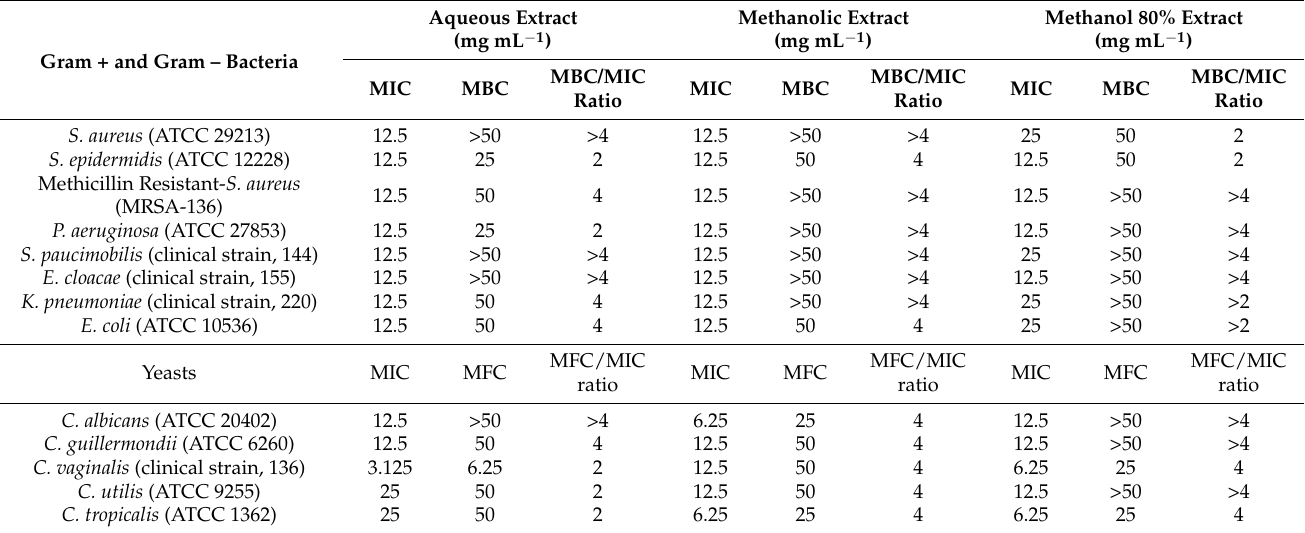
Table 6. MIC, MBC, and MFC values obtained for bacterial and yeast strains tested using microdilution assay.